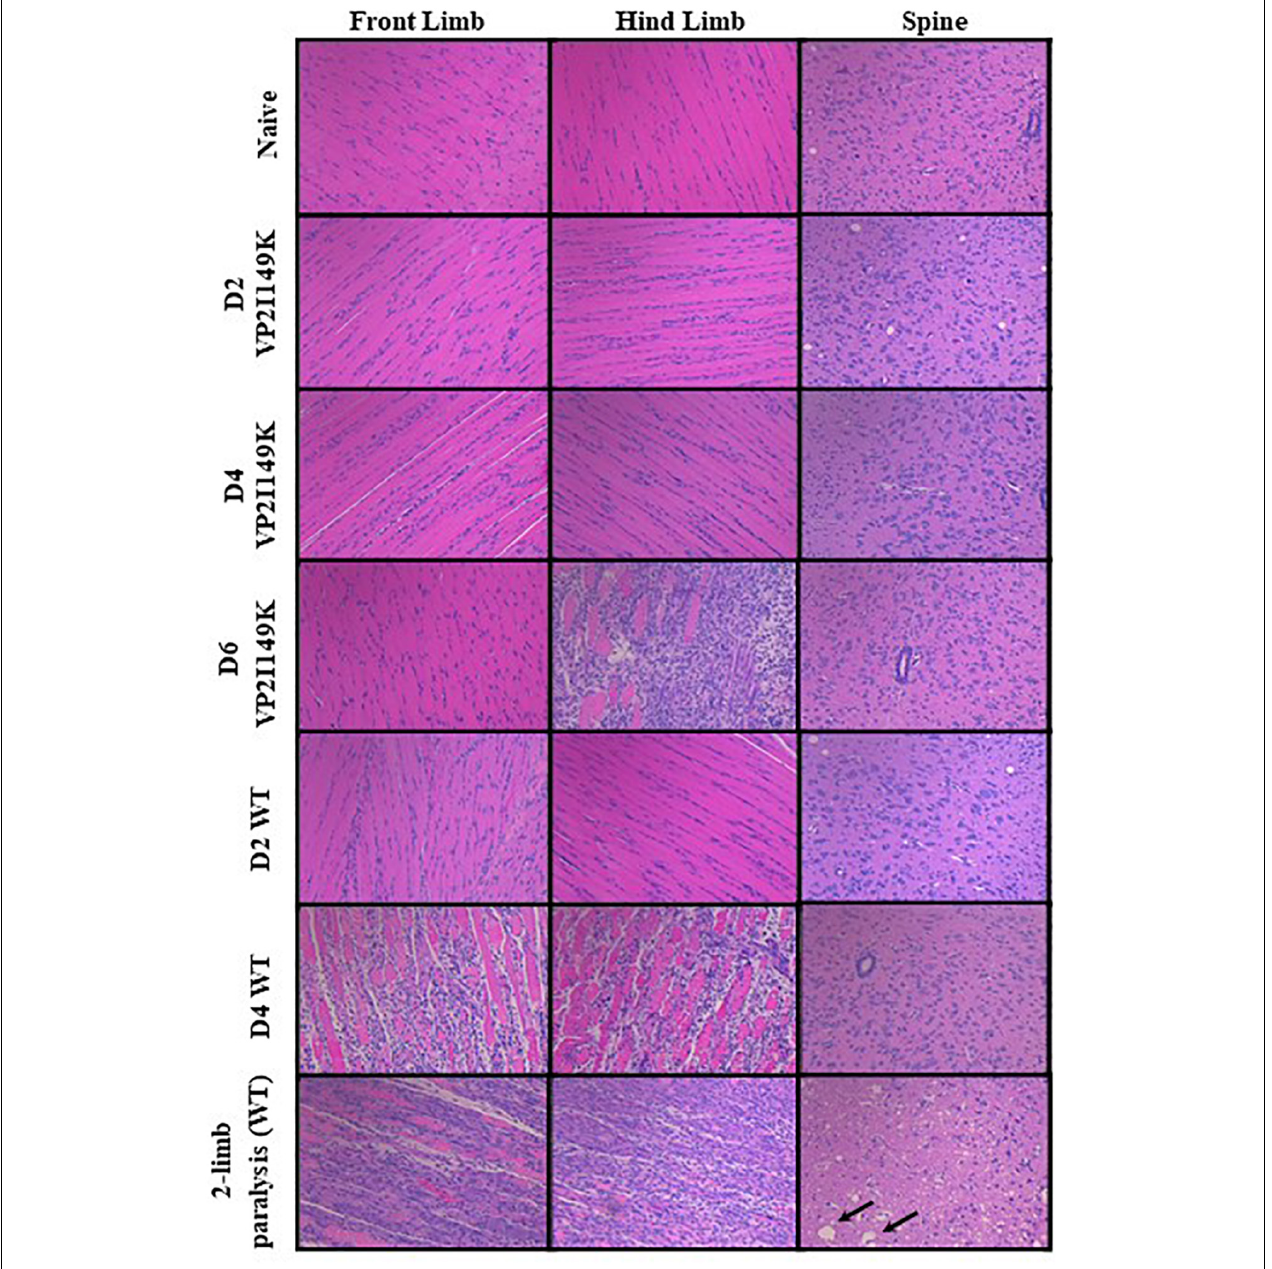
FIGURE 7 | Histopathological analysis of virus-infected mice. Two-week-old AG129 mice ( n = 3) were infected intraperitoneally with WT or VP2 I149K mutant. Uninfected control mice were administered with PBS instead (naïve). Mice were euthanized upon observation of two-limb paralysis, or at the indicated time-points, and organs were harvested and processed for H&E staining. Black arrows indicate neuropil vacuolation and neuronal degeneration in the anterior horn region of the spinal cord. All observations were made at 20 × magnification. The scale bar denotes 100 µ m. Representative images are